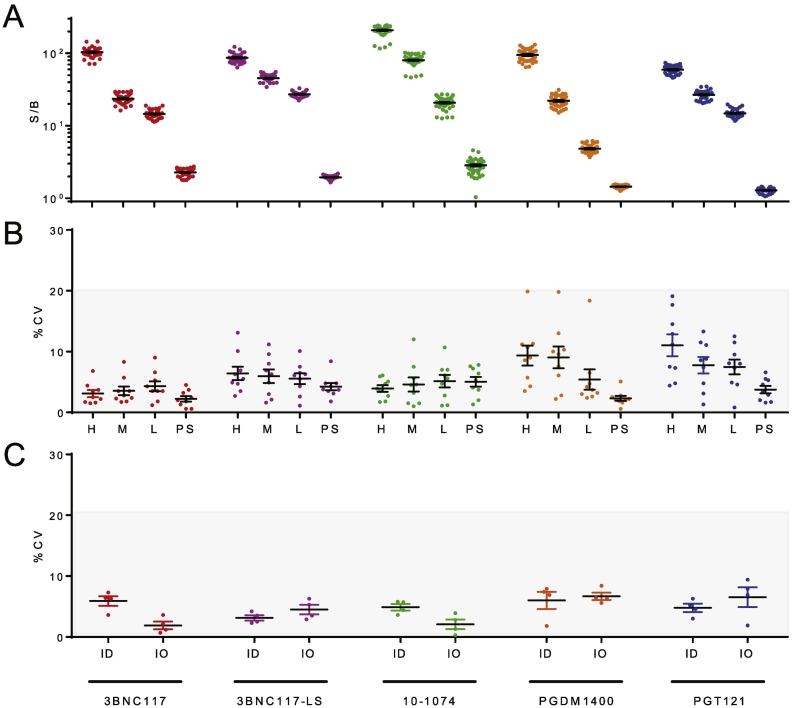
Intra and inter-assay variability. A-B. Intra-assay variability. S/B (A) and percent coefficient of variation (%CV) (B) for technical replicates (N = 35–46) of the high (H), medium (M), and low (L) anti-id concentration control samples and pooled sera (PS) are plotted. C. Inter-assay variability as assessed by measuring the coefficient of variation between inter-operator (IO) and inter-day (ID) measurements. Bar and whiskers indicate mean and standard error of the mean. The range of %CVs generally recommended as acceptable for biophysical assays is indicated in gray.